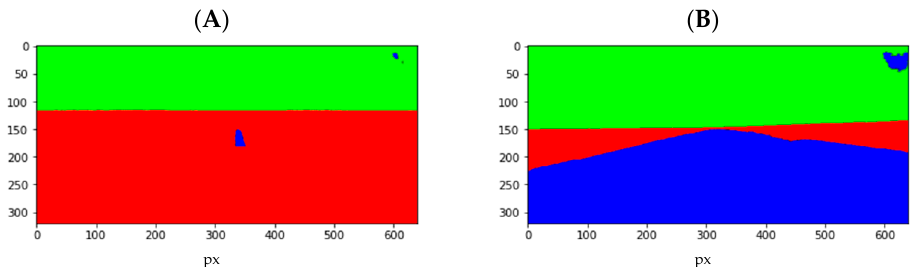
Figure 3. Example of runway segmentation (based on U-Net framework) at a long distance ( A ) and in its immediate vicinity ( B ).